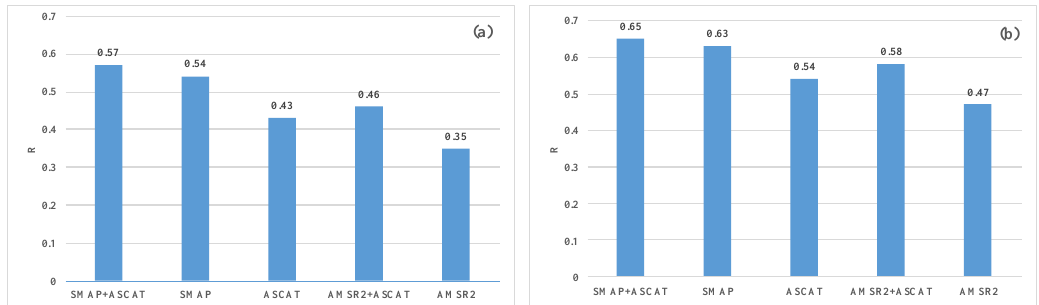
Figure 13. Bar graphs for the overall averages of temporal correlations coefficients for two merged and parents SM datasets against the modeling SM products: ( a ) GLDAS; and ( b ) ERA5.